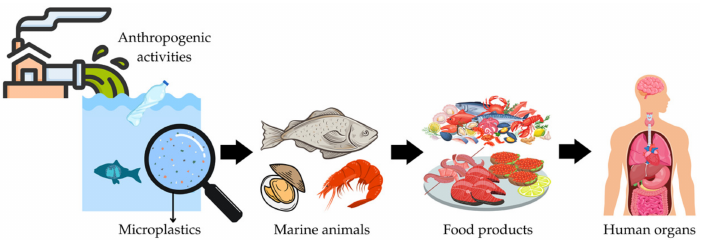
Figure 1. A model showing how anthropogenic activity cause microplastics to enter the food web, make a path to our food and, ultimately, into our